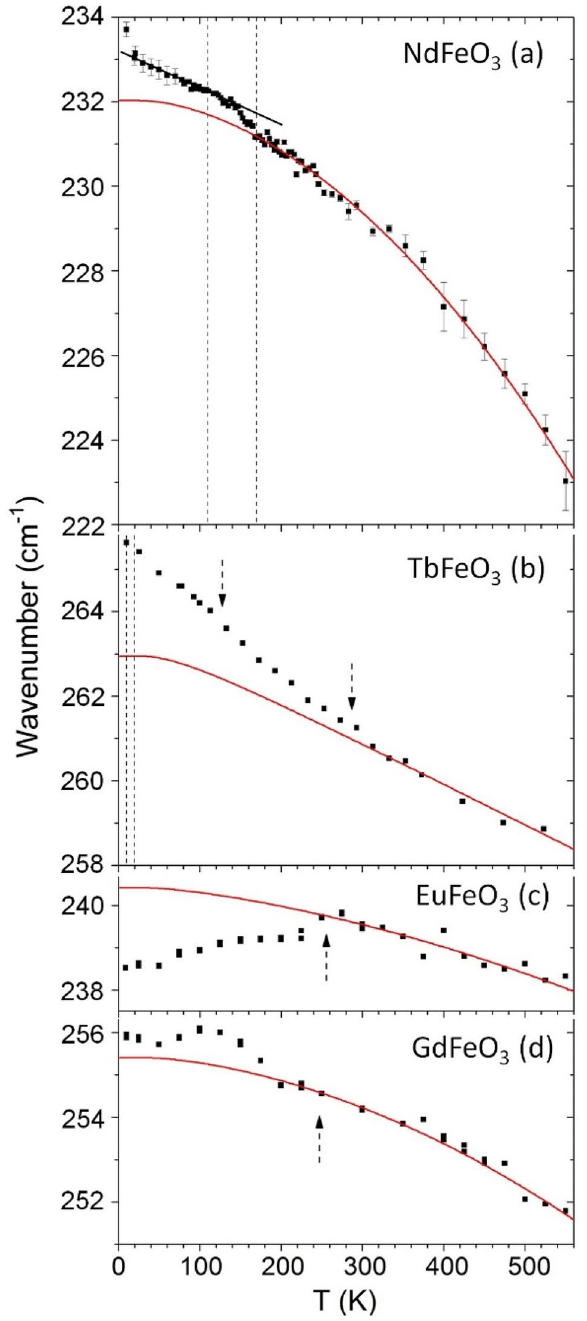
Figure 6. Temperature dependence of the [010] pc in-phase octahedra wavenumber for NdFeO 3 , TbFeO 3 , EuFeO 3 and GdFeO 3 . The solid curves were determined by the best fits of the anharmonic temperature law above 200 K (for NdFeO 3 and GdFeO 3 ) and 300 K (for TbFeO 3 and EuFeO 3 ) and its extrapolation down to 0 K 35 . Vertical dashed lines mark the phase transition temperatures following Ref. 13 , while dashed arrows mark relevant M(T)